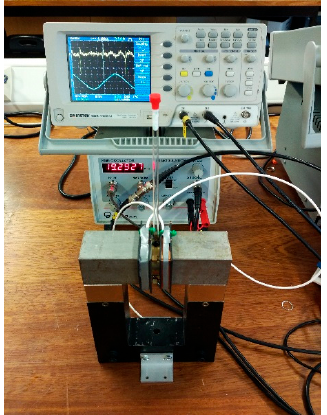
Figure 22. Electromagnets can be substituted for low-cost, modern NdFeB magnets.